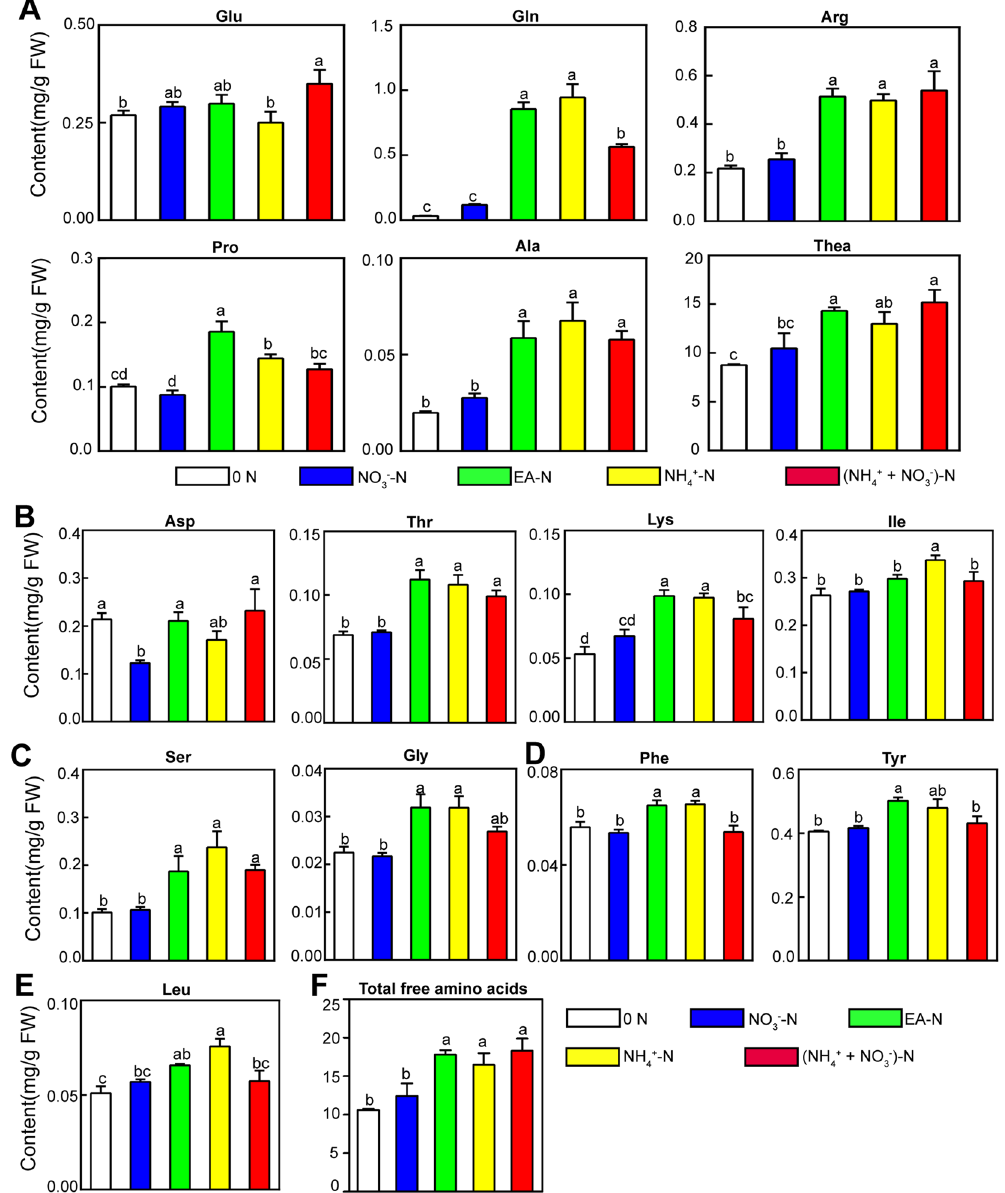
Figure 3. Effects of N forms and 0N on accumulation of amino acids in tea plant roots. The contents of 15 amino acids were determined in tea plant roots under various forms of N and 0 N treatments. Ala: Alanine; Ser: Serine; Gln: Glutamine; Pro: Proline; His: Histidine; Gly: Glycine; Arg: Arginine; Thr: Threonine; Lys: Lysine; Tyr: Tyrosine; Thea: Theanine; Leu: Leucine; Phe: Phenylalanine; Asp: Aspartic acid; Ile: Isoleucine; Glu: Glutamic acid. Data shown are the average mean ± SE of three replicates (n = 3). Different letters indicate statistical significance among different treatments according to Duncan’s multiple range test at the 5%